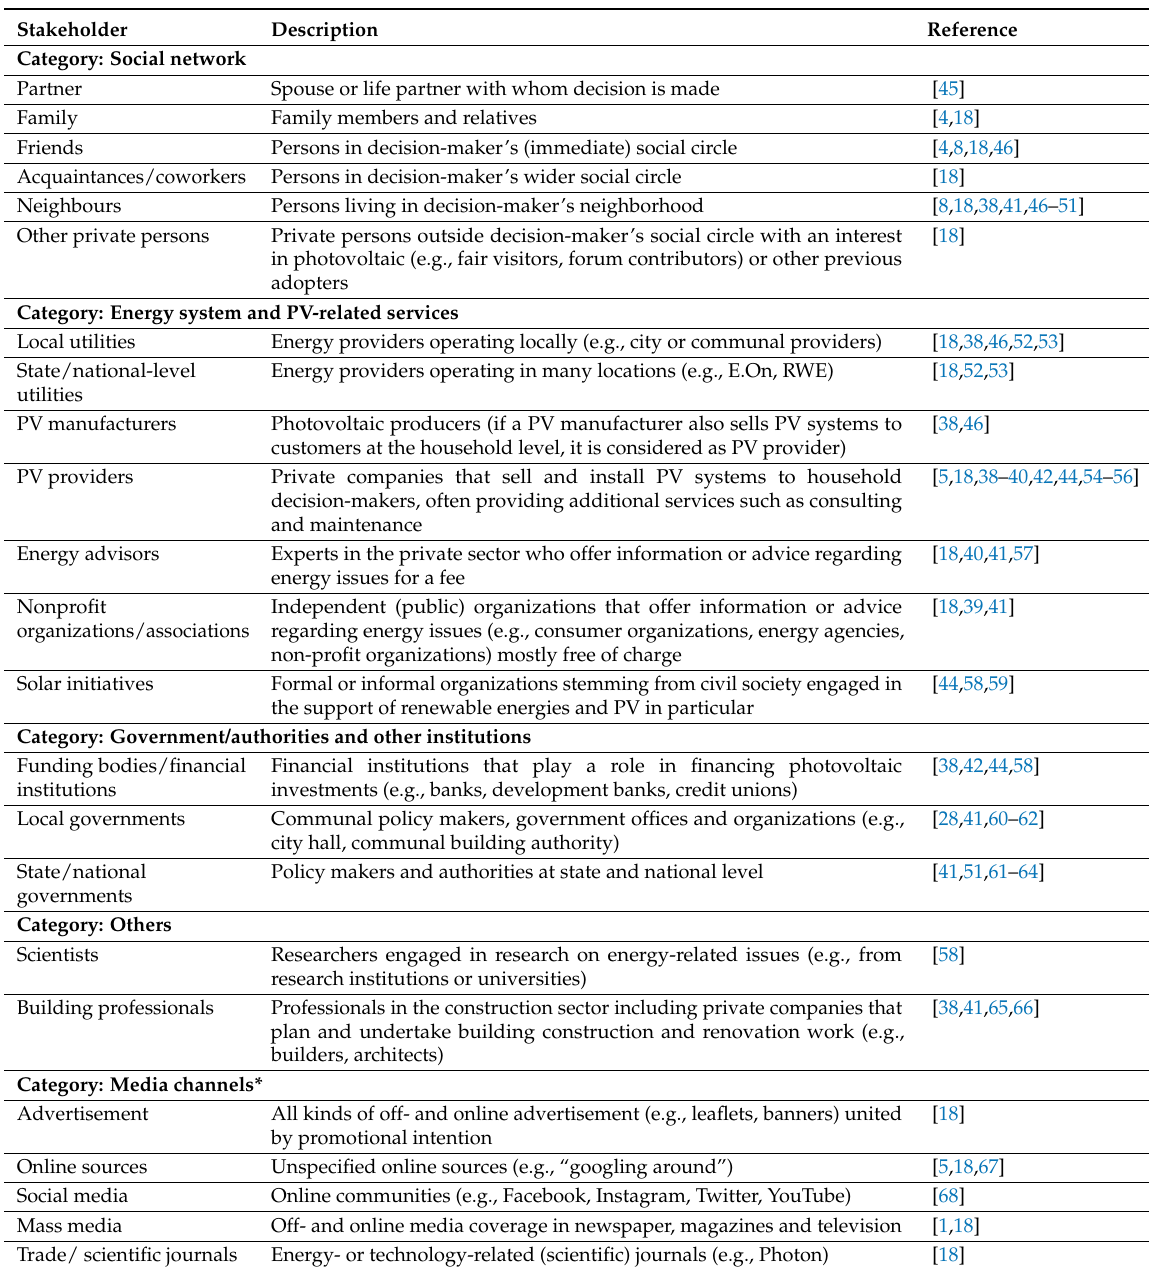
Table 1. Stakeholder mapping and classification based on their role in the PV adoption processes (own